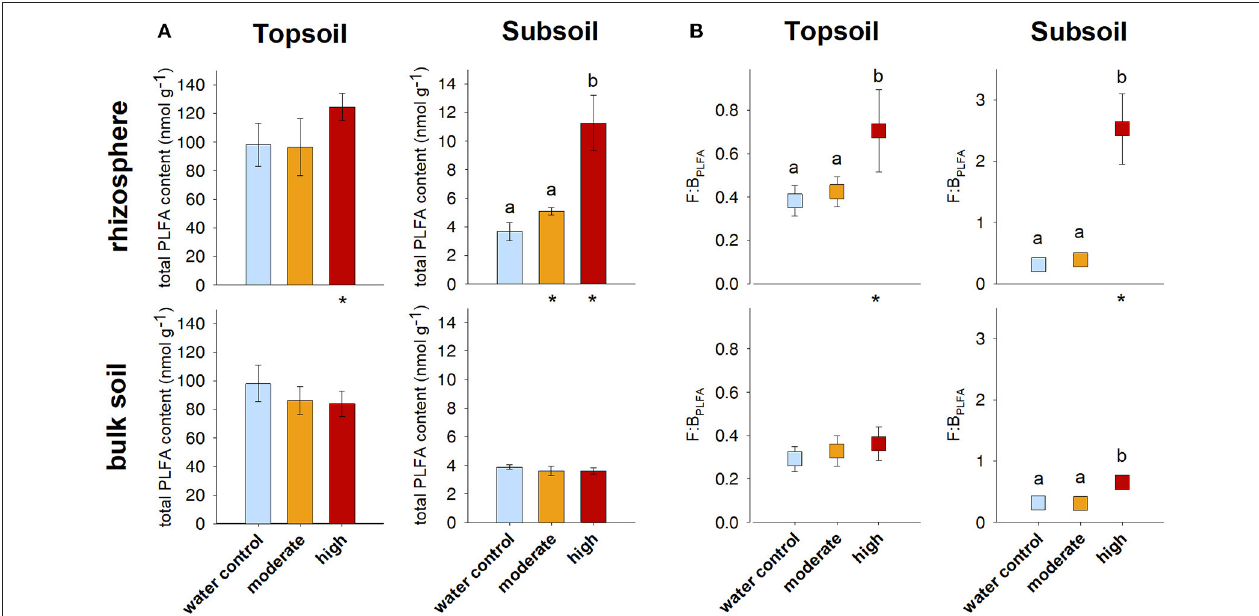
FIGURE 3 | (A) Total microbial PLFA content and (B) fungal-to-bacterial ratio based on PLFA analysis (F:B PLFA ). Bars represent standard deviation from the mean (SD). Different letters indicate statistically significant differences between the treatments within one soil region and depth ( p < 0.05), asterisks indicate statistically significant differences between the soil regions rhizosphere and bulk soil within one soil depth and treatment.